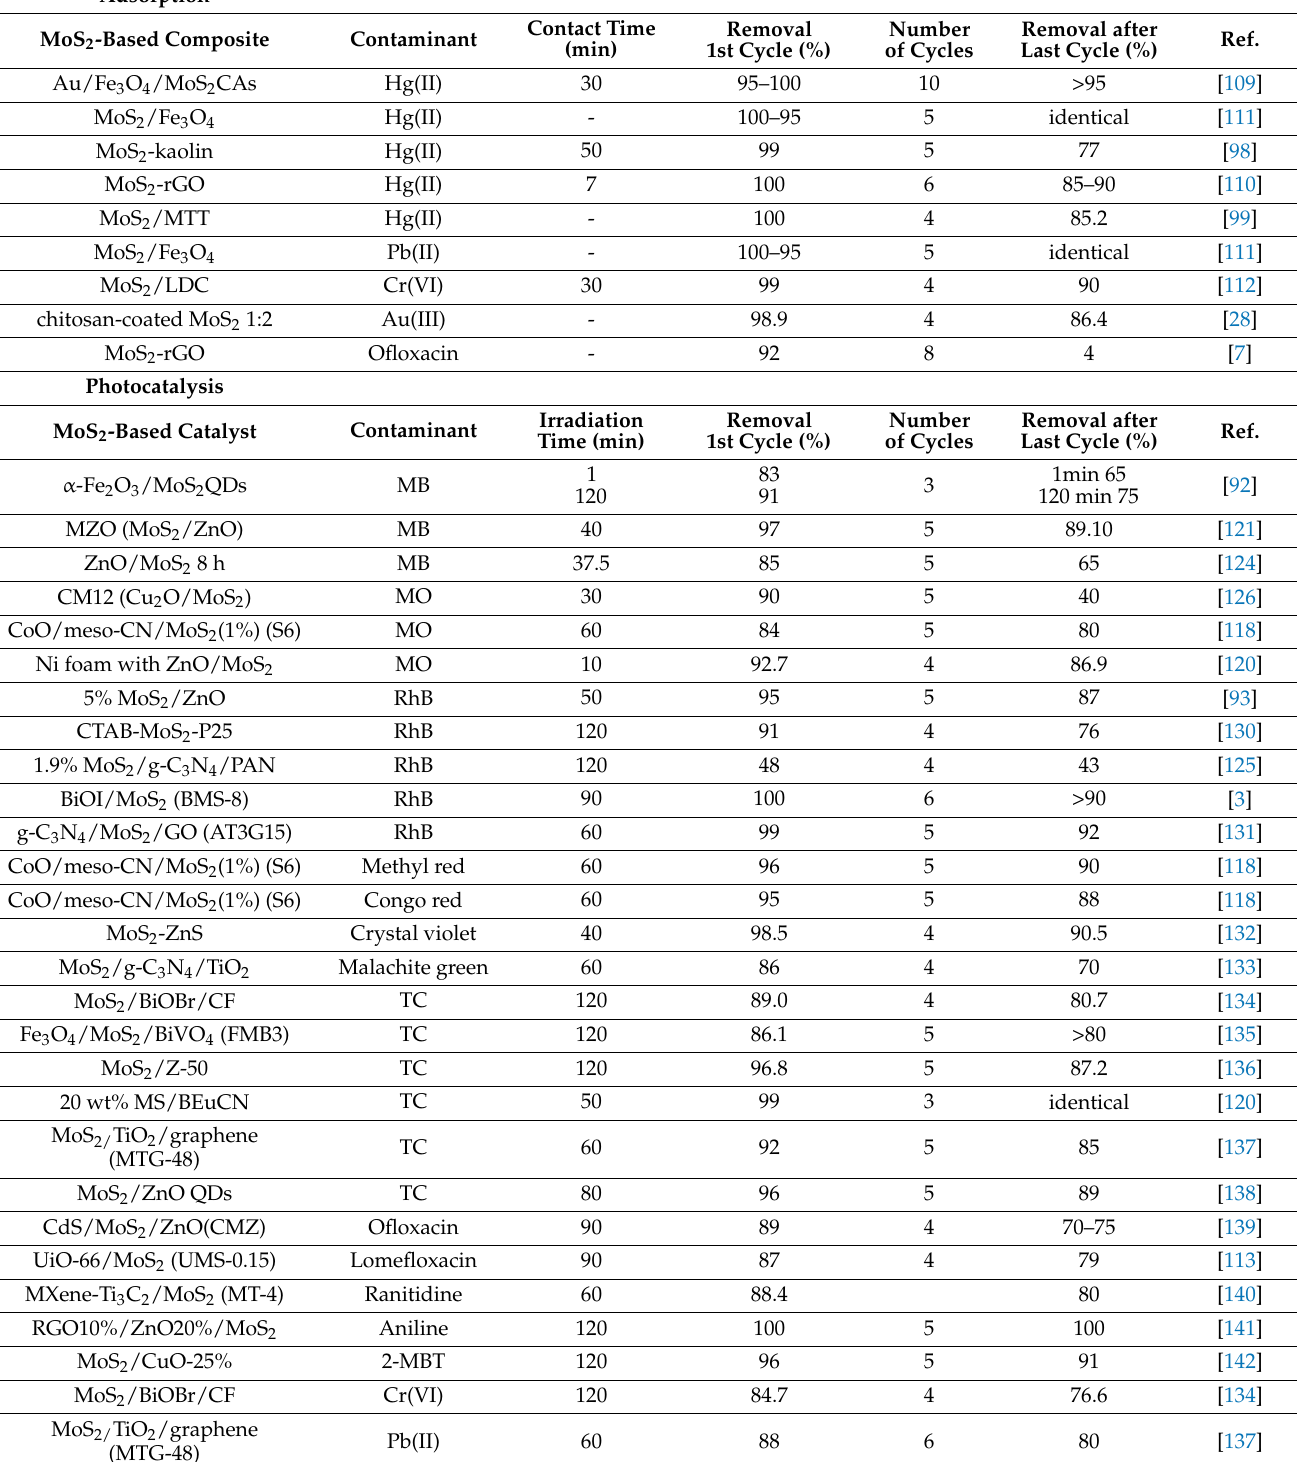
Table 5. Reuse of MoS 2 -based sorbents and